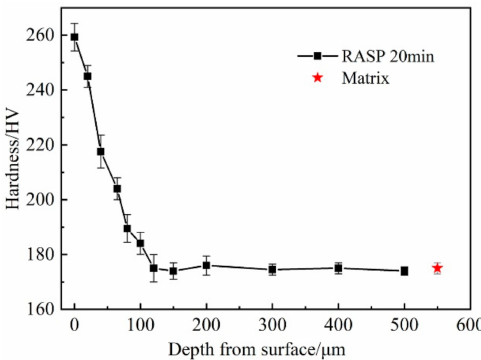
Figure 2. Hardness gradient as a function of depth for the RASP-processed for 20 min